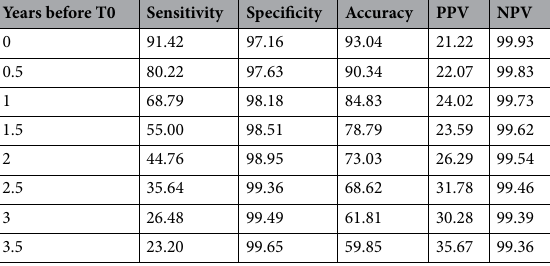
Table 3. Model predictive performance metrics. For all PPV and NPV calculation the prevalence was fixed at 0.83% (overall data set